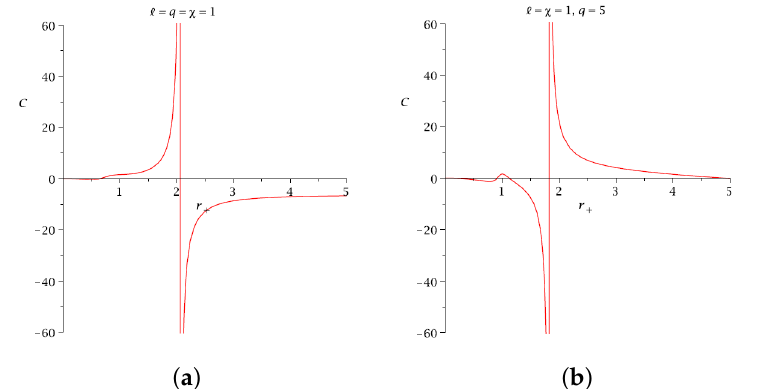
Figure 2. In this figure, we have plotted the variation of specific heat C i with horizon radius ( r + ) for the values χ = 1 ( a ) and (cid:96) = 1 ( b